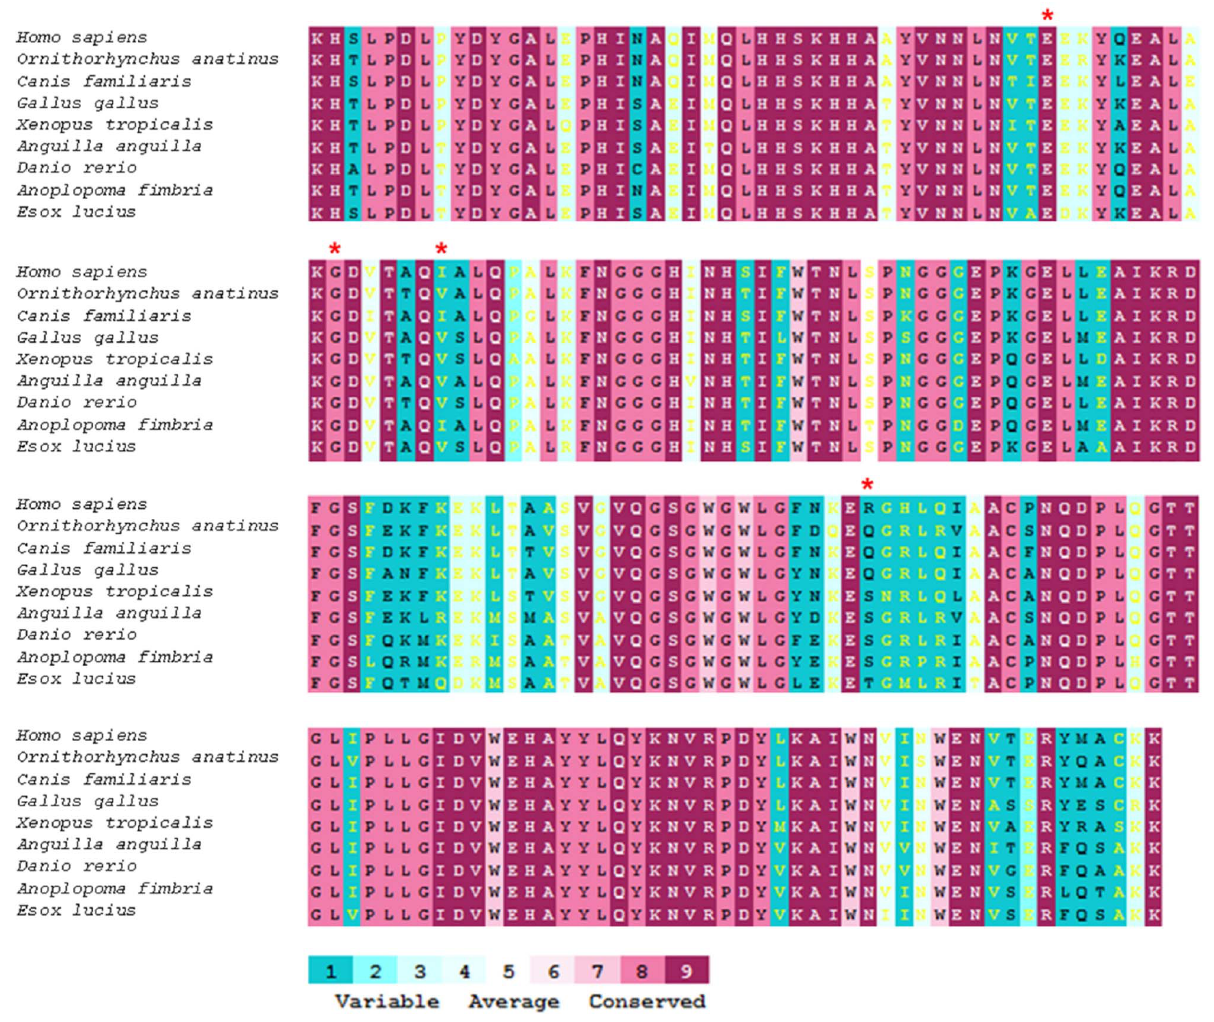
Figure 4. Conservation profile of the Mn-SOD (PDB ID: 1LUV) using ConSurf conservational analysis. Mn-SOD is represented as a spacefill model, where the residue conservation scored is colour-coded onto the surface. The backbone model represents the other chain of a Mn- SOD dimer, chain B. The colour-coding bar shows the colouring scheme: conserved amino acids are coloured bordeaux, residues with average conservation are white, and variable amino acids are turquoise.